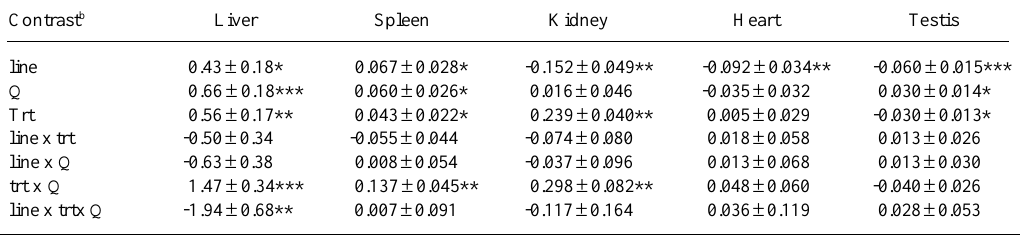
Table VIII - Orthogonal contrasts ± SE within lines TC and TM a for organ weights as a percentage of 8-week body weight (%). Contrast